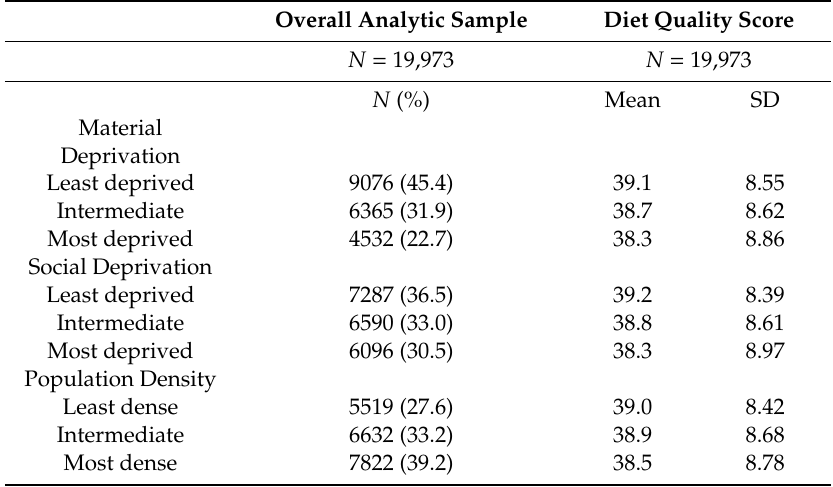
Table 2. Percentage of participants with high diet quality and mean diet quality scores by categories of neighbourhood environment.